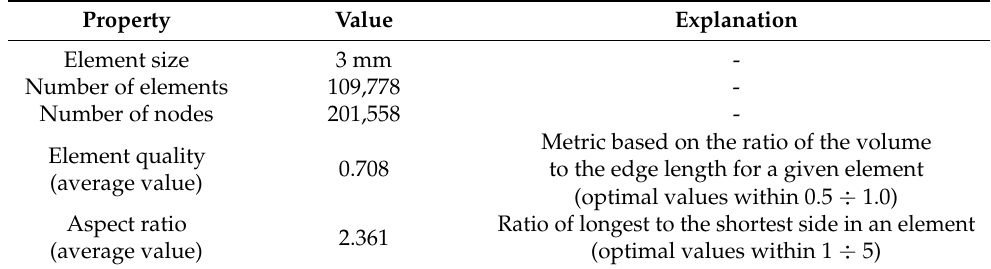
Table 3. Mesh properties for the FE camshaft-cover model.